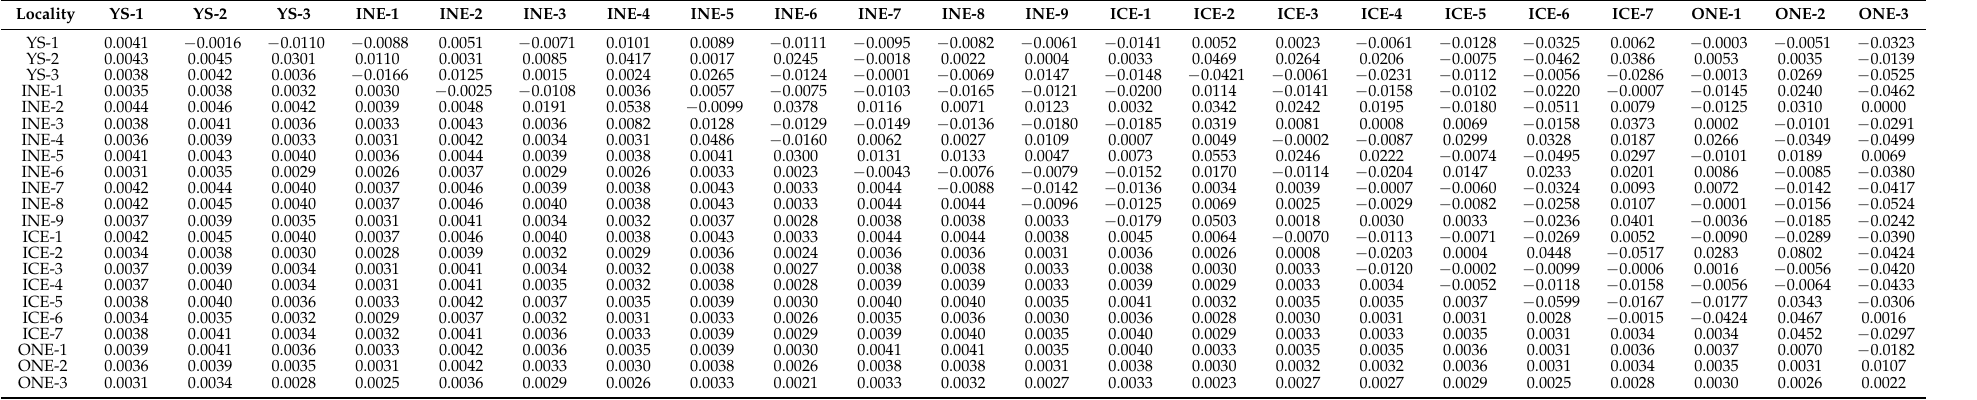
Table 2. Summary statistics of COI sequences in four groups of the large yellow